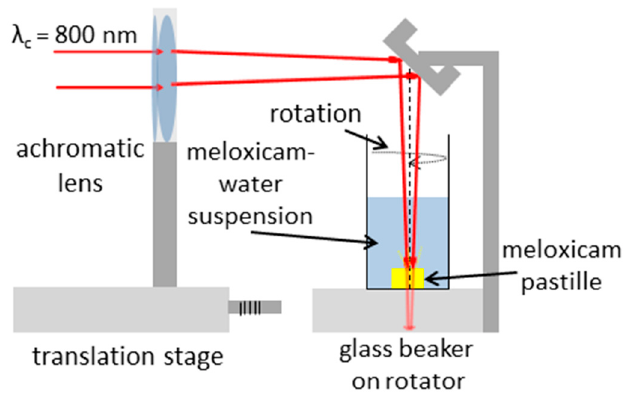
Figure 2. Experimental setup for pulsed laser ablation in